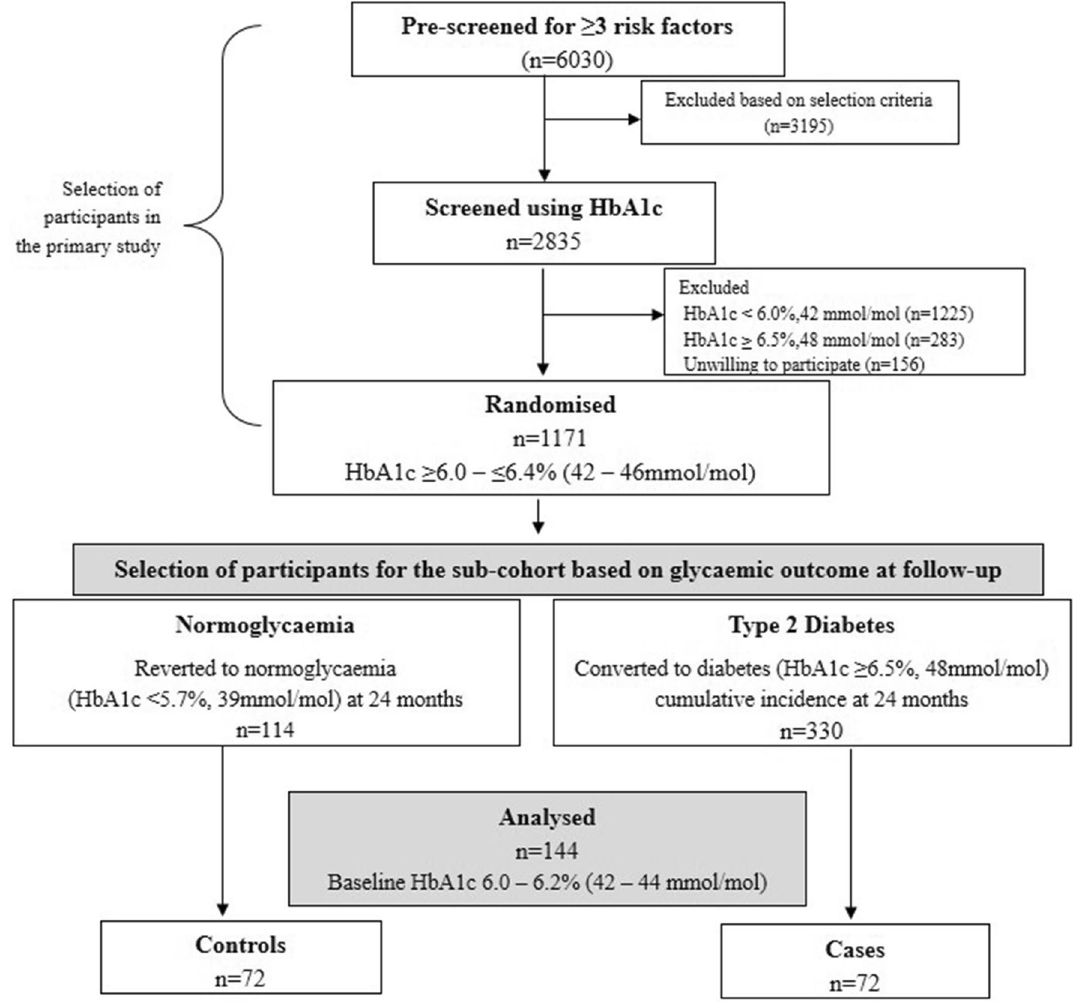
Figure 2. Steps involved in the selection of the study